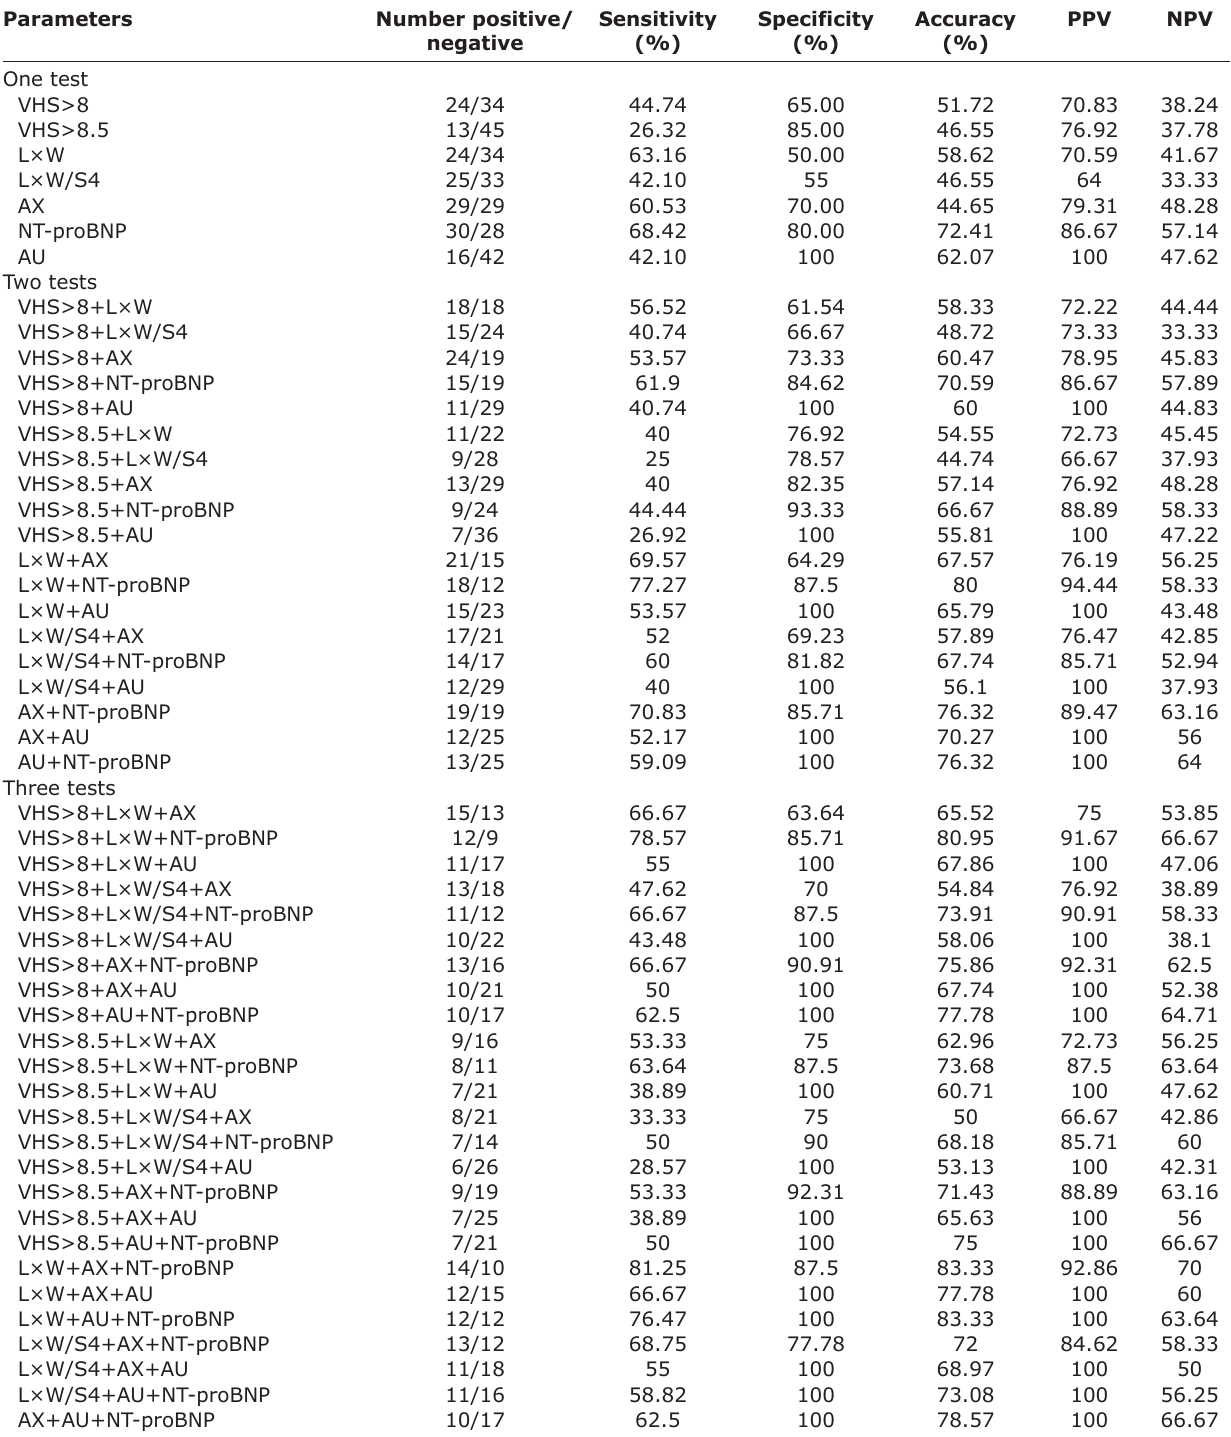
Table-1: Specificity, sensitivity, accuracy, positive predictive, and negative predictive values for each test in cats with (n=38) and without heart disease (n=20).